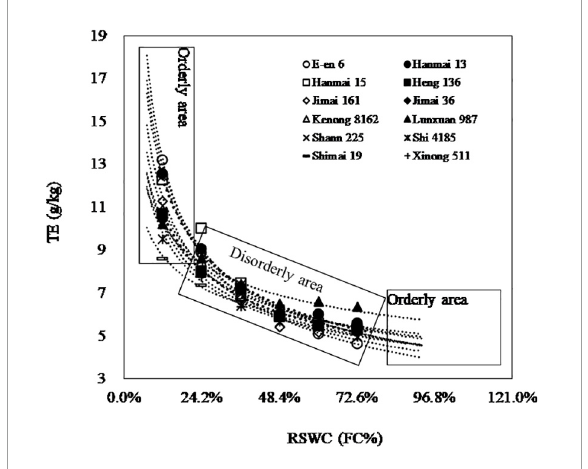
FIGURE6 The rank of TE shoot among cultivars at different RSWC levels. The curves can be divided into orderly area where the rank of cultivars is stable when RSWC ≤ 12.1% or RSWC ≥ 72.6% and disorderly area where the rank is instable when 3% < RSWC < 18%, when comparing among number of cultivars. TE shoot , the ratio of shoot mass to transpiration loss. RSWC , soil water content. FC , field capacity. Data are shown as mean, n =